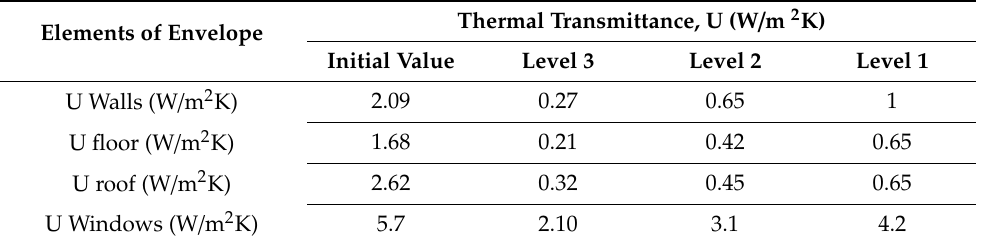
Table 7. Value of studied thermal transmittances.